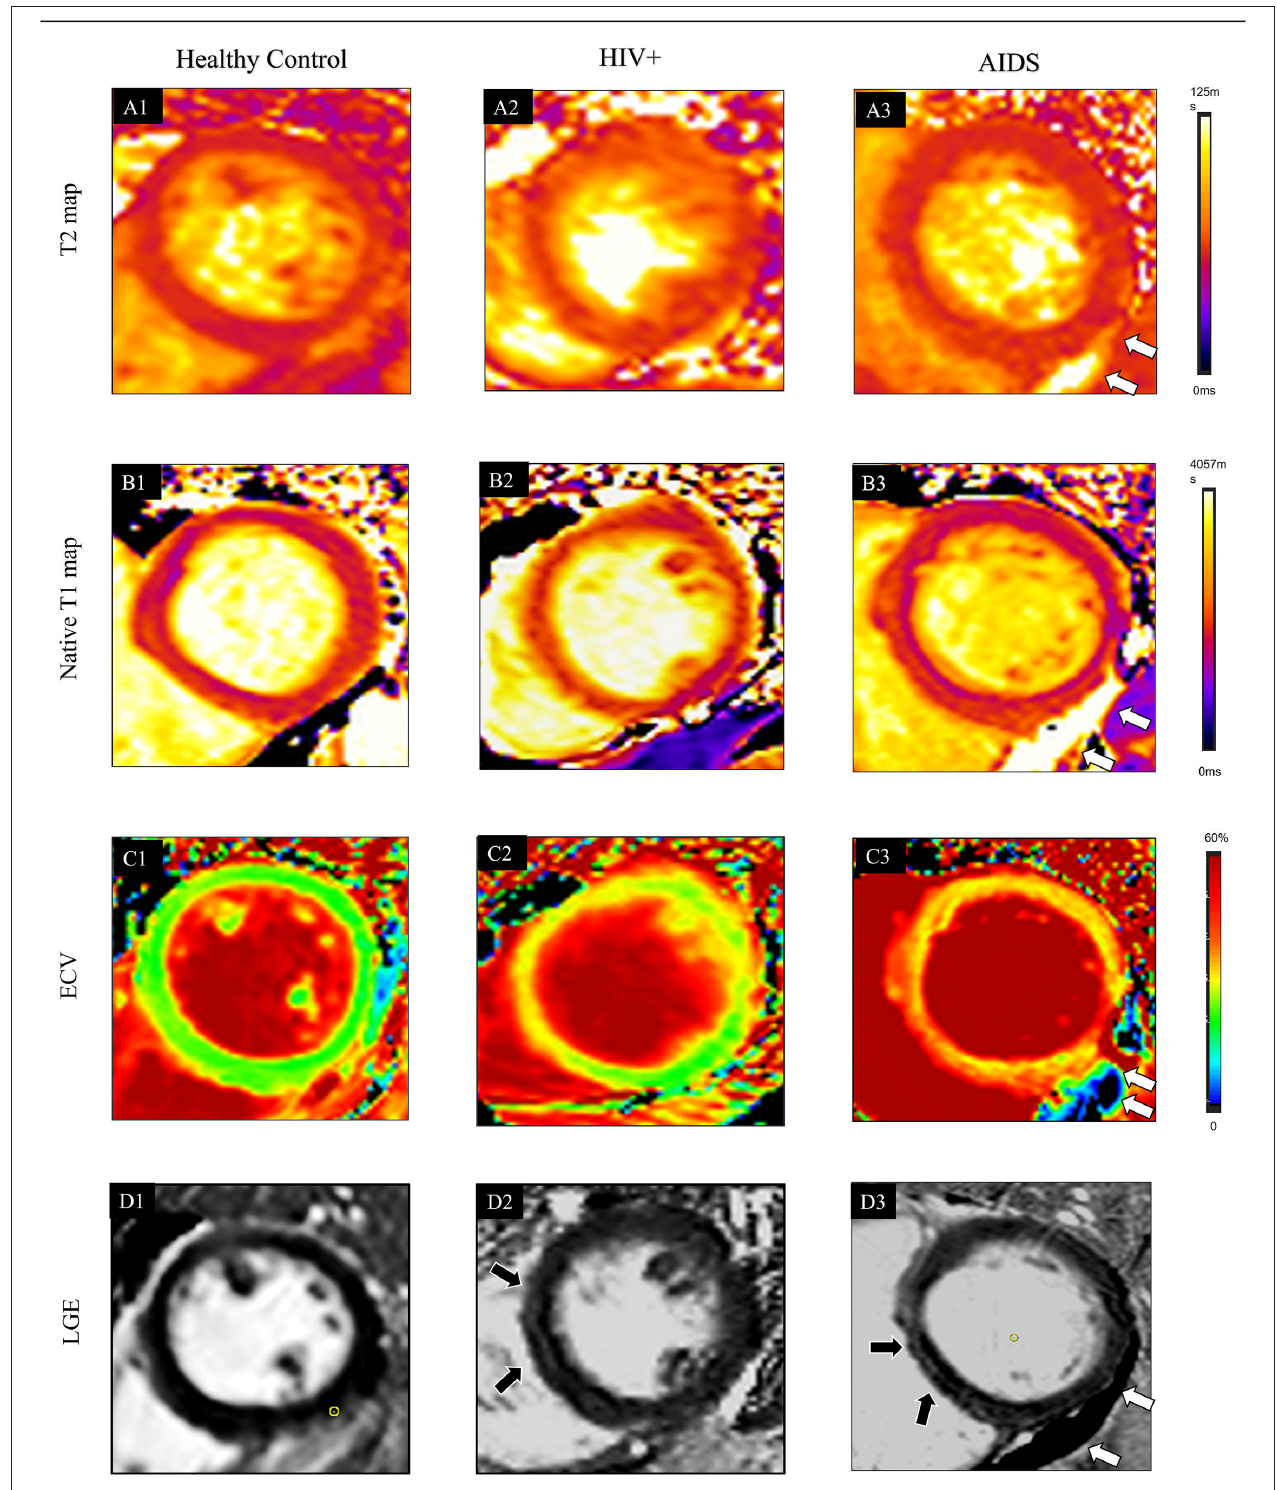
FIGURE 3 | Typical cases showed comprehensive CMR parameters in a healthy control participant (38-year-old man, A1–D1 ), HIV + patients (47-year-old man, A2–D2 ), and AIDS participant (38-year-old man with the complication of pneumocystis carinii pneumonia; A3–D3 ). Quantitative maps include cardiac T2